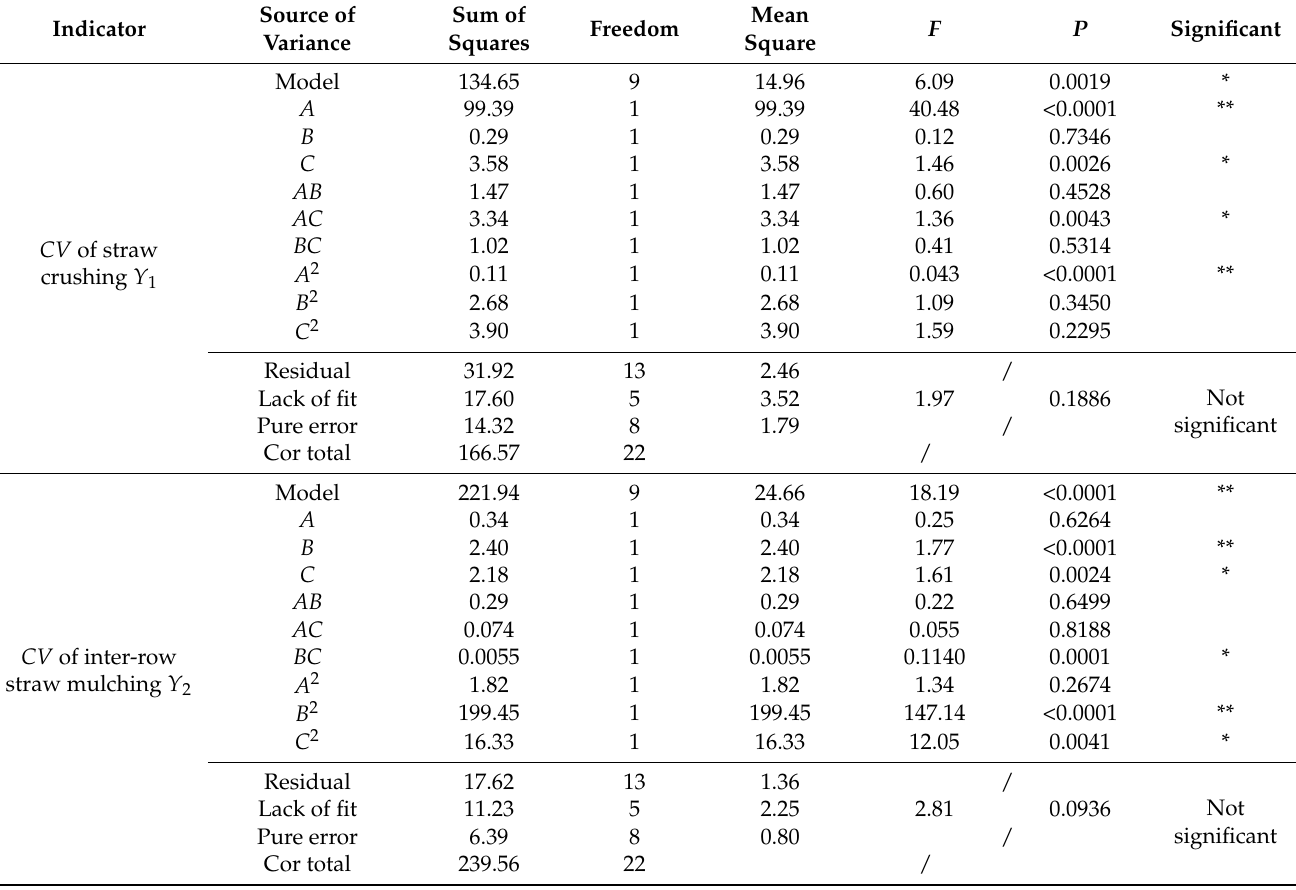
Table 4. ANOVA analysis of the regression